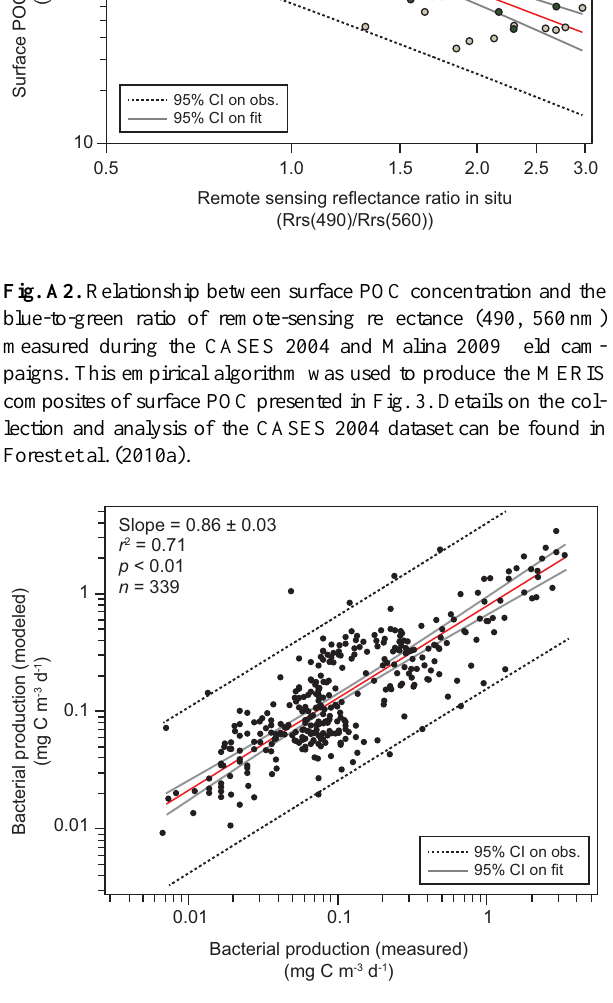
Fig. A3. Fit between bacterial production (BP) calculated using a multiple linear regression model (i.e., study-specific model based on chlorophyll a concentration, beam attenuation coefficient and water temperature recorded in situ; see Appendix D) and BP measured with classical leucine uptake experiments during the Malina cam- paign. We used a conversion factor of 1.2kgC per mole of leucine to transform 3 H-leucine incorporation into carbon